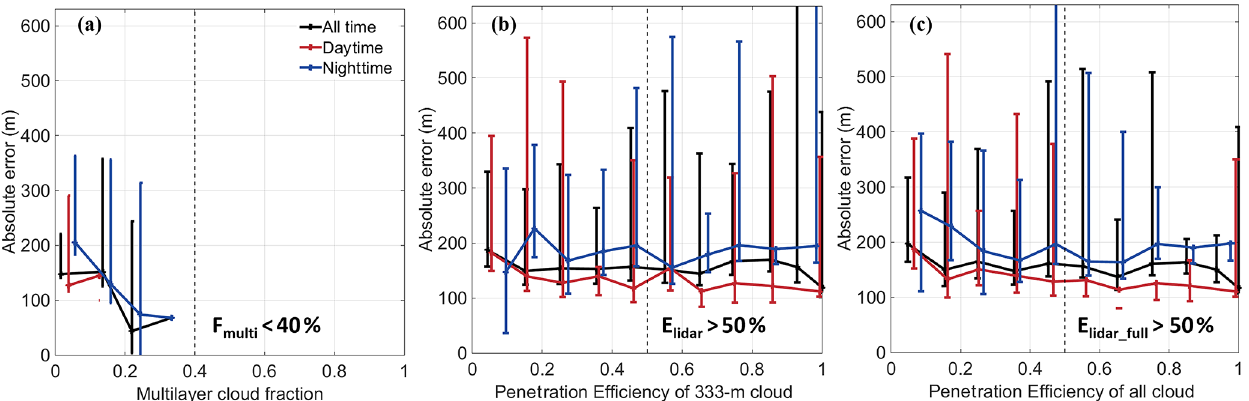
Figure A3. (a) Joint distribution of CBH absolute error (between CALIPSO CBH and ceilometer CBH) and multilayer cloud fraction of 138 continental ceilometer sites in the southern Great Plains in 2017–2020 with distance less than 50km. The different colored lines represent different times (the black line: all time; the red line: daytime; the blue line: nighttime). The standard error is shown by error bars. Panel (b) is the same as panel (a) but for penetration efficiency of 333m resolution cloud. Panel (c) is the same as panel (a) but for penetration efficiency of all clouds.